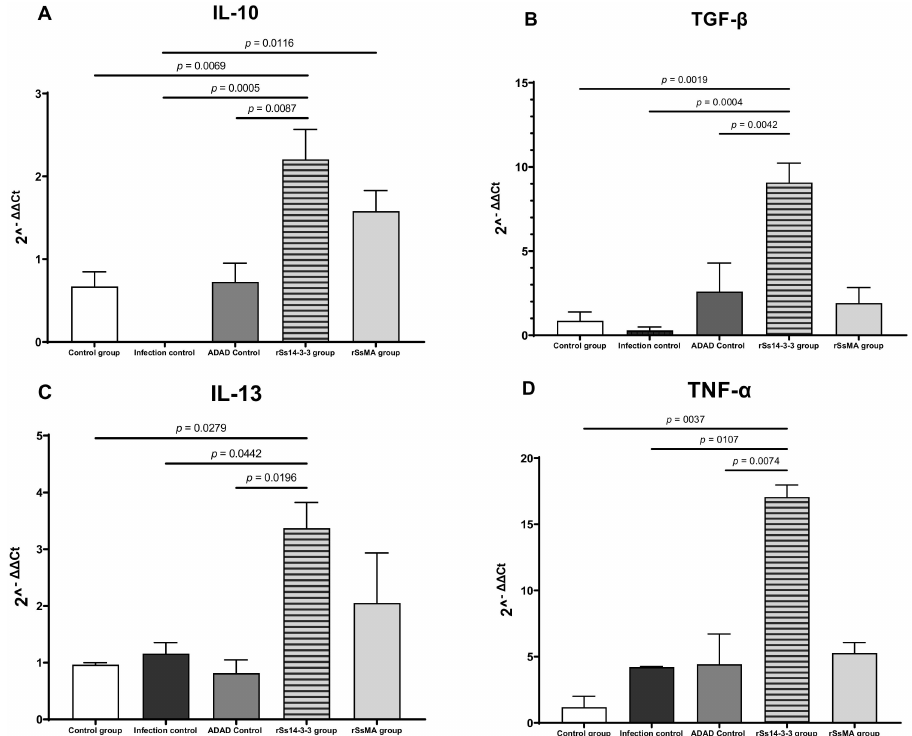
Figure 6. Expression levels of IL-10, TGF- β , IL-13 and TNF- α in spleen of mice immunized with rSs14-3-3 and rSsMA formulated in ADAD and challenged with 3000 S. venezuelensis infective L3. ( A ) IL-10 mRNA levels; ( B ) TGF β mRNA levels; ( C ) IL-13 mRNA levels; ( D ) TNF α mRNA levels. Bars represent means ± SEM. Data were evaluated by one-way ANOVA analysis for each cytokine IL-10 (F (4,9) = 13; p = 0.0007); TGF- β (F (4,19) = 1; p = 0.0001); IL-13 (F (4,10) = 5; p = 0.0152; TNF- α (F (4,6) = 12; p = 0.0042). Post-hoc Tukey’s honestly significant difference (HSD) test p -values are shown in the